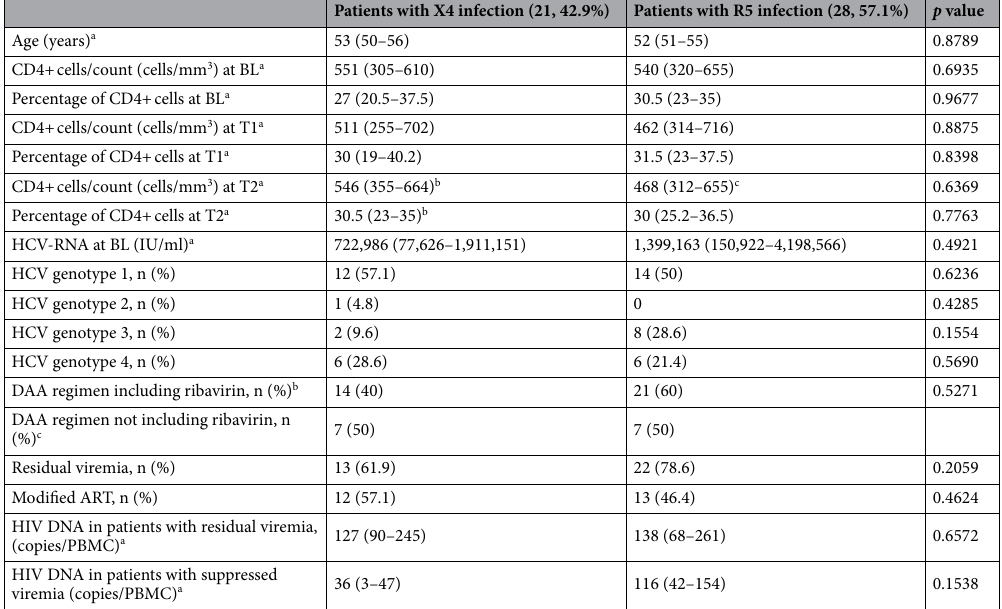
Table 2. Characteristics of the HIV HCV patients with X4 tropic virus and with R5 tropic virus infection at baseline (BL). a Median and interquartile range. b Percentage calculated with respect to the 35 patients treated with a DAA regimen including ribavirin. c Percentage calculated with respect to the 14 patients treated with a DAA regimen not including ribavirin. DAA direct-acting antivirals, PBMC peripheral blood mononuclear cells, ART antiretroviral therapy, T1 week 12 of anti-HCV treatment, T2 week 24 after HCV treatment started.